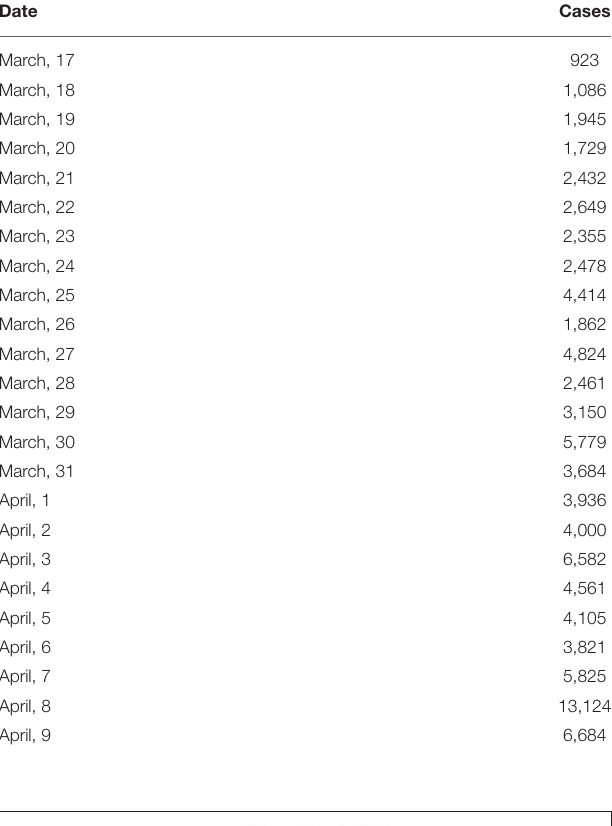
TABLE 1 | Data of SARS-Cov-2 infections for the USA, China, Italy, and Spain, in 2020, recoiled on https://www.ecdc.europa.eu/sites/default/files/documents/